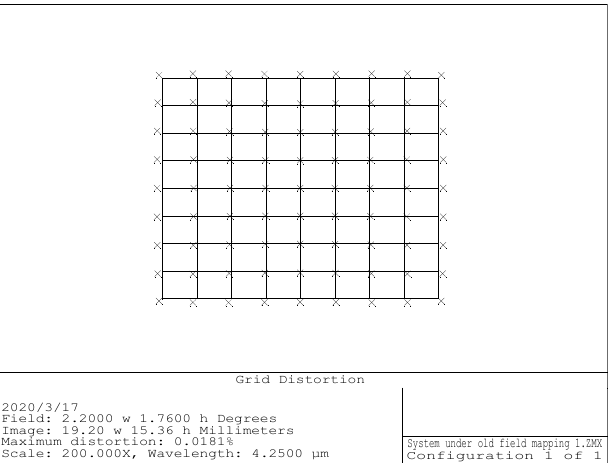
Figure 9. Grid distortion of the optical system in Figure 8. The X point is the actual field point, and the grid is the theoretical field point. In order to visually display the distortion characteristics, the distortion deviation is enlarged by 200 times.